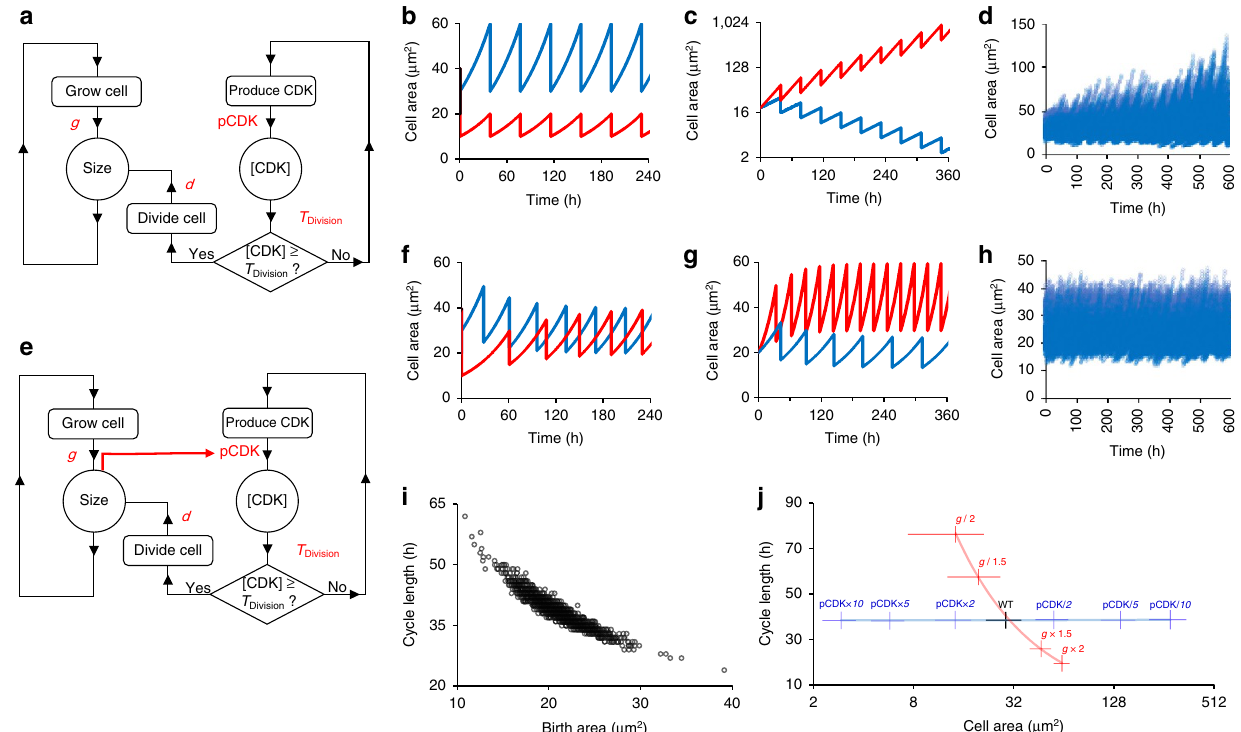
Figure 4 | Cell size dependent progression of the cell cycle is sufficient to produce an inverse relationship between cell size and cell cycle length and homeostasis of cell size. ( a ) Schematic of model wiring. Model consists of a growth loop (left hand side) and a CDK loop (right hand side). With each time step, size and CDK concentration are recalculated according to the relative growth rate ( g ) and the rate of production of active CDK (pCDK), respectively. When the concentration of CDK rises above the threshold level ( T Division ) cell division is triggered and cells divide according to a division ratio d . ( b , c ) Simulation results for model where pCDK and T Division are independent of cell size. Simulations are run without variation in g or d and are designed to test the effect an uneven division ( b ) or a change in RGR ( c ). In the uneven division test the simulation is initiated with a large cell (blue) and a small cell (red). In the RGR test, the simulation was run with increased (red) or decreased (blue) relative growth rate g . Graphs show cell size over time, representing a period of at least six division cycles. ( d ) Simulation where pCDK and T Division are independent of cell size, including variation in g and d according to observed values. The population is initiated with 100 asynchronous cells. ( e ) Schematic of model wiring. Growth loop and CDK loop are integrated by making the production of CDK dependent on size (red arrow). ( f , g ) Simulation results where pCDK is directly proportional to cell size. Simulations of an uneven division ( f ) and a change in RGR ( g ) were run as above ( b , c ). ( h ) Simulation using model with pCDK directly proportional to cell size, including variation in g and d according to observed values. The population is initiated with 100 asynchronous cells. ( i ) Relationship between cell size and cell cycle length in individual cells in a simulated population of 100 asynchronous cells. ( j ) The effect of altering RGR (red) and pCDK (blue) on the distribution of cell sizes and cell cycle lengths in a population of 100 cells simulated as above. T Division is unaltered. Relative fold changes in parameter values relative to WT values are indicated on the graphs. Note that altering pCDK changes cell size, but not cell cycle length. Data points represent means, error bars represent